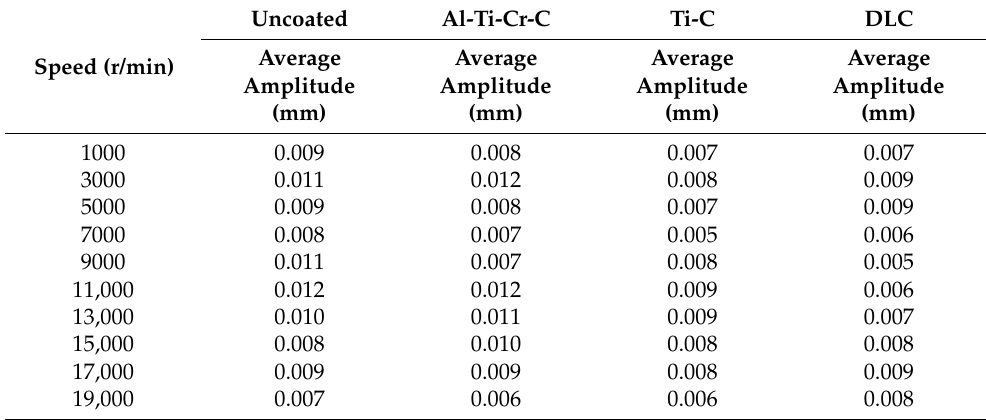
Table 3. The change graph of rotation amplitude-speed.